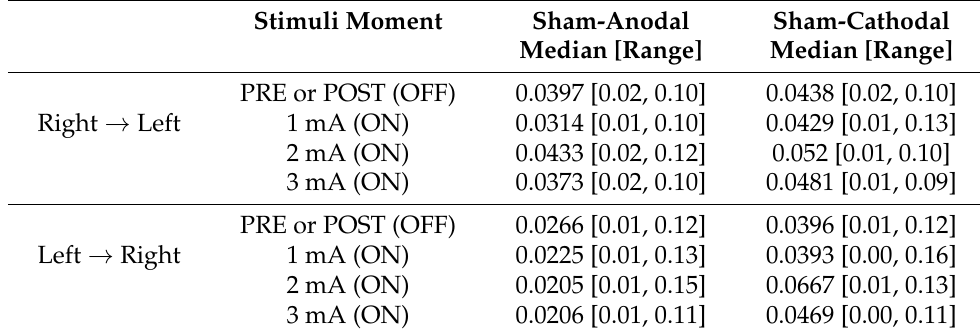
Table 1. Descriptive comparison between Sham-Anodal and Sham-Cathodal.